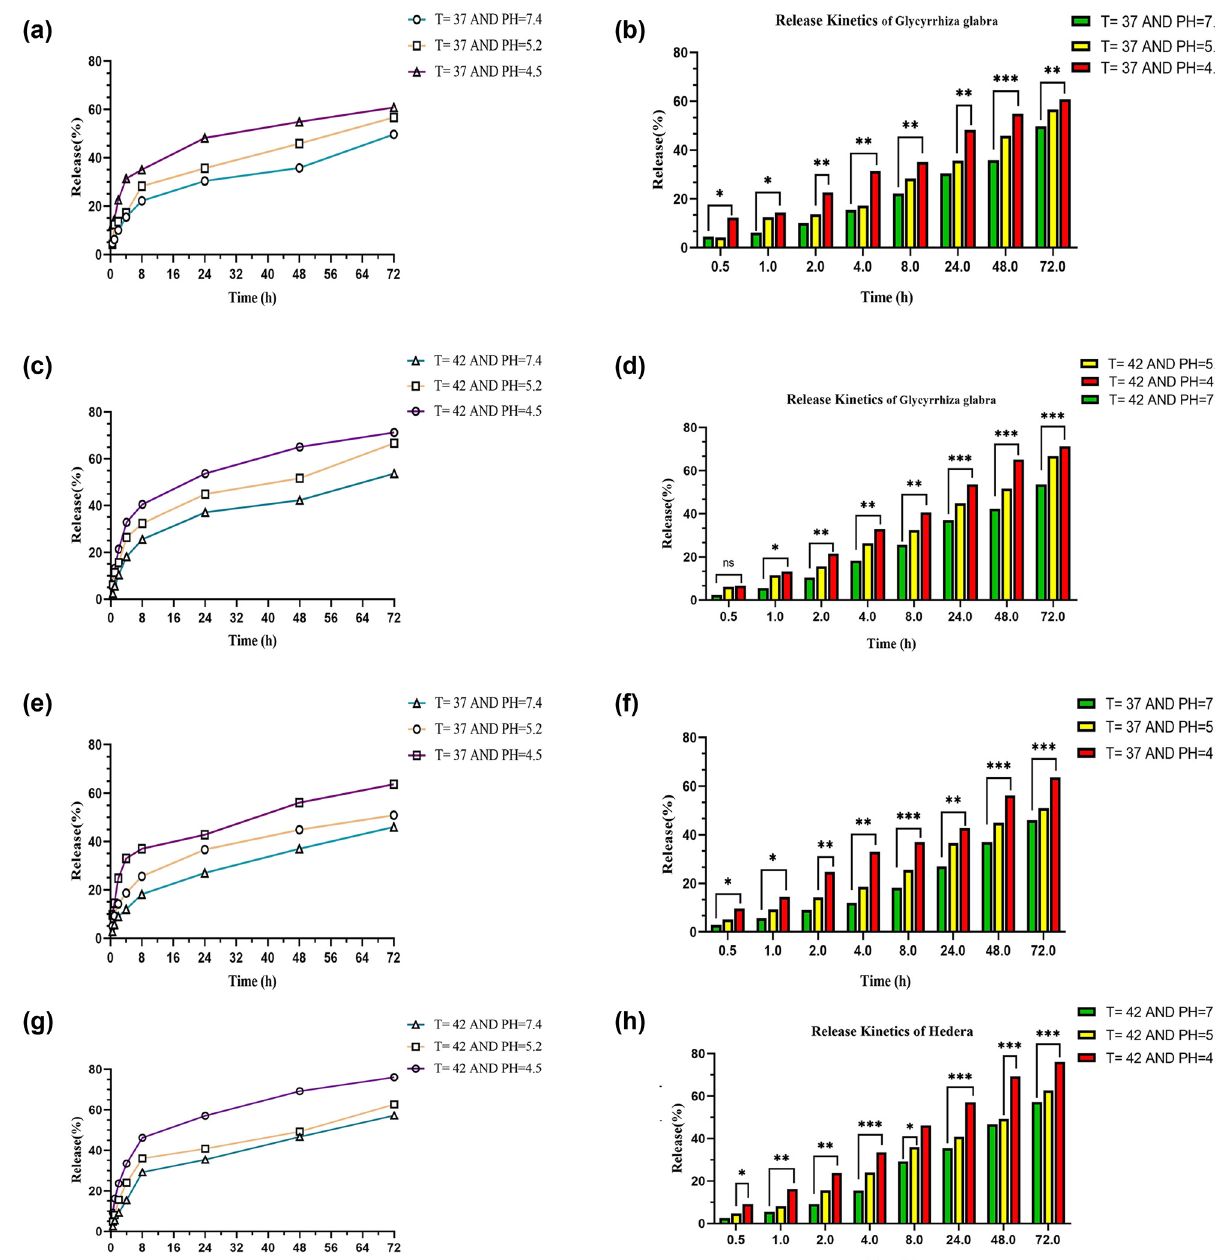
Figure 7: Thermo - pH sensivity release of extracts from nanoniosomes assay. ( a ) Release of GGE from nanosystem at constant temperature and variable pH. ( b ) Statistical analysis data of GGE release from nanosystems at constant temperature and variable pH. ( c ) Release of GGE from nanosystem at constant pH and variable temperature. ( d ) Statistical analysis data of GGE release from nanosystems at constant pH and variable temperature. ( e ) Release of HHE from nanosystem at constant temperature and variable pH. ( f ) Statistical analysis data of HHE release from nanosystem at constant temperature and variable pH. ( g ) Release of HHE from nanosystem at constant pH and variable temperature. ( h ) Statistical analysis data of HHE release from nanosystems at constant pH and variable temperature. *, **, ***: P - value <